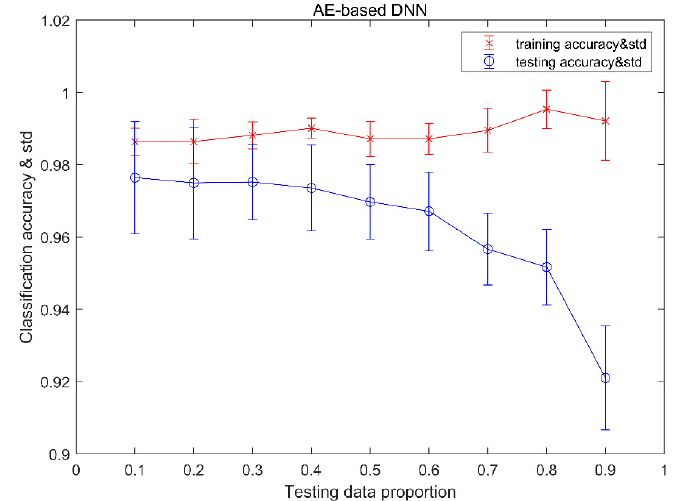
Figure 8. The classification accuracy and the standard deviation of AE-based DNN